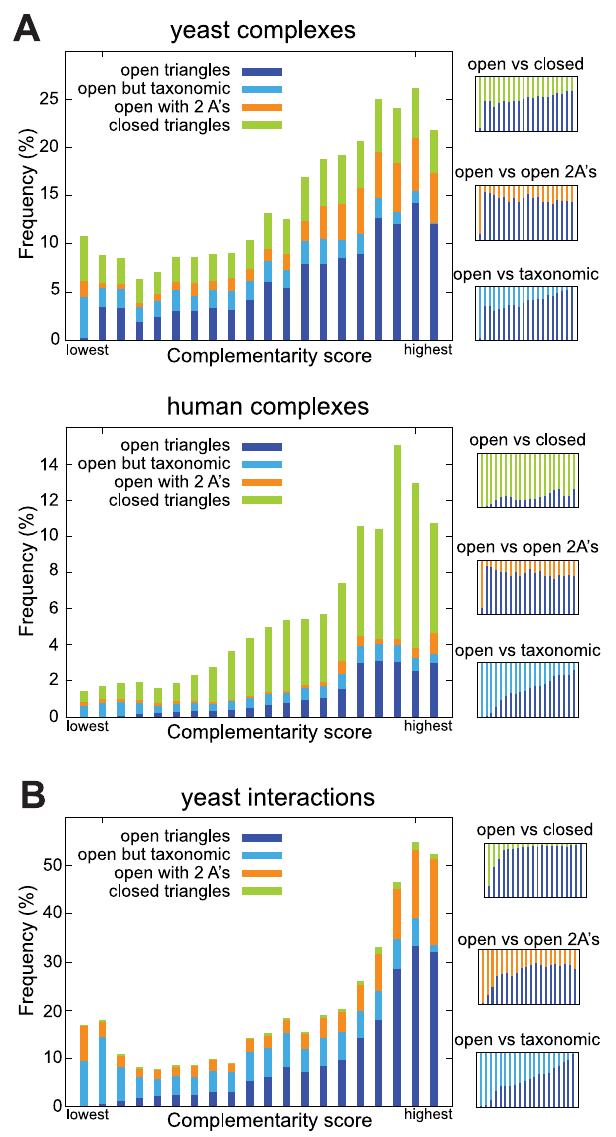
Figure 3. Frequency of open triangles as a function of the triplet score for (A) co-complex protein pairs and (B) yeast interactions. Each bar corresponds to an equally-sized bin, with the right-most bar belonging to the best scoring triplets. The three small plots on the right side of the figures displays ratios between different categories.